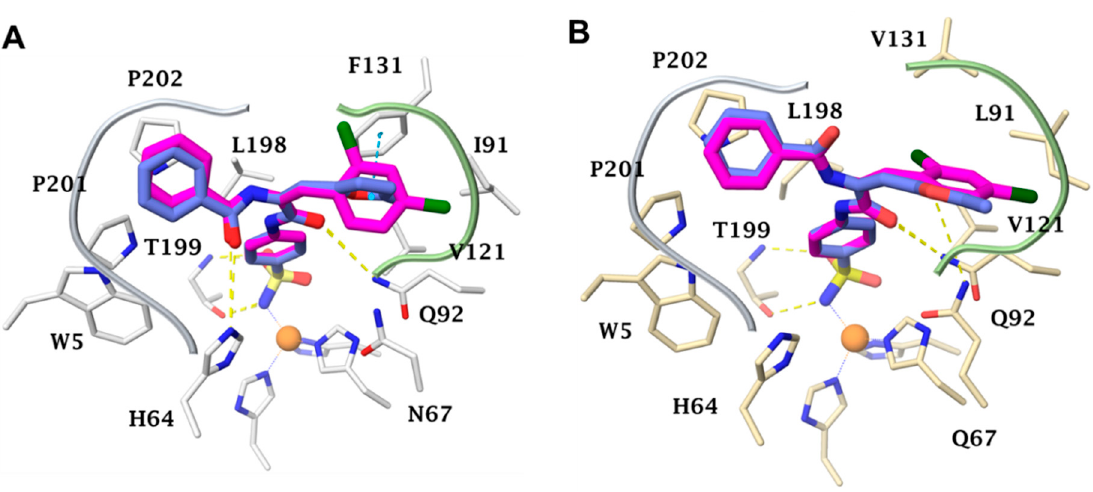
Figure 5. Docking of 5b (purple) and 5h (violet) in hCA II ( A ) and in hCA IX ( B ) active sites.